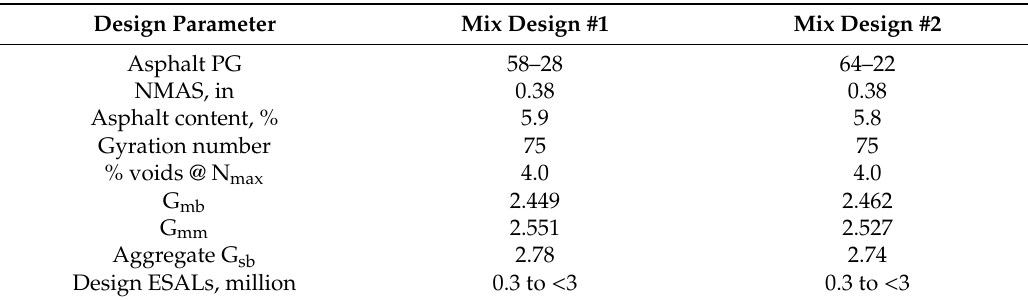
Table 1. Mix design